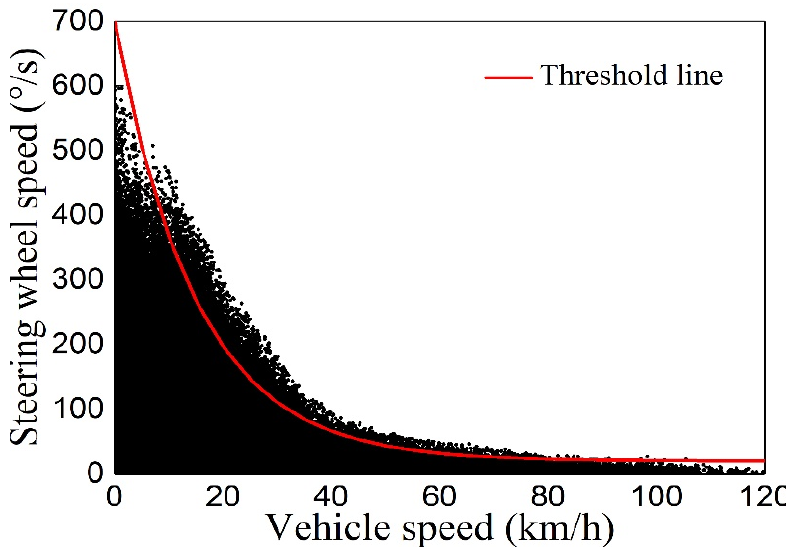
Figure 15. The distribution of steering wheel speed and threshold of abnormal steering action.